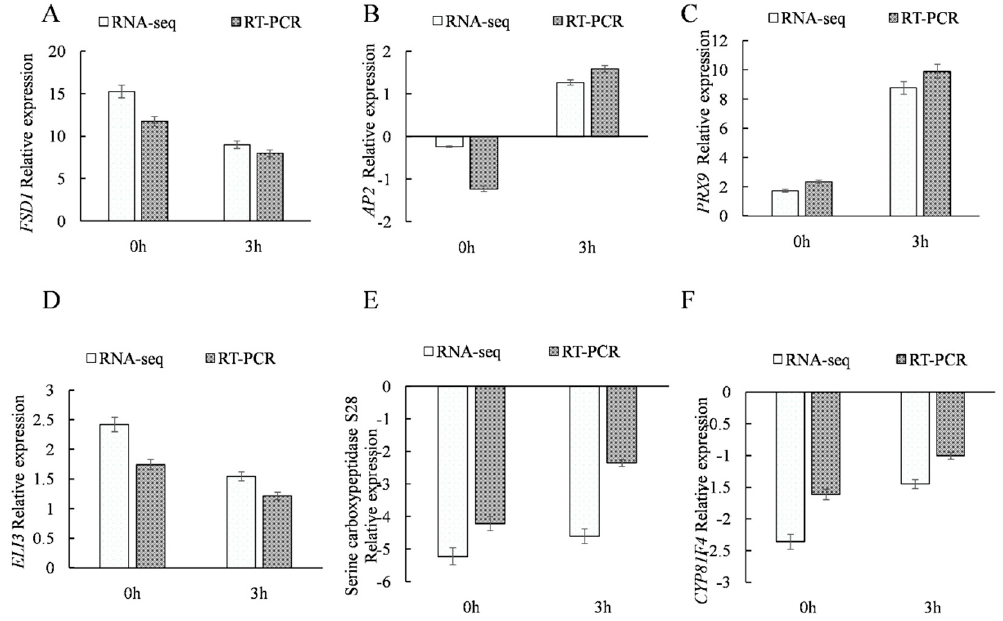
Figure 9. The expression levels of the genes were studied at 0 h and 3 h of exposure to 150 mM NaCl. ( A ) AT4G25100.2; ( B ) AT4G34400.1; ( C ) AT1G44970.1; ( D ) AT4G37990.1; ( E ) AT4G36190.1; ( F ) AT4G37410.